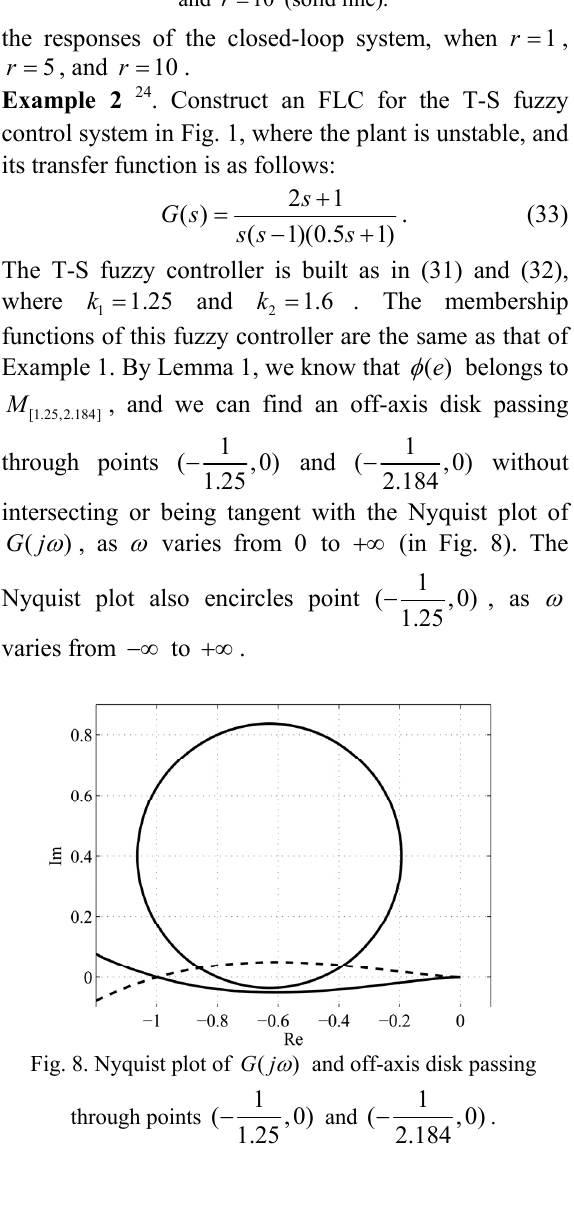
Fig. 7. Responses of T-S fuzzy control system, when 1 r = (dash line), 5 r = (dash-dot line), and 10 r = (solid line).